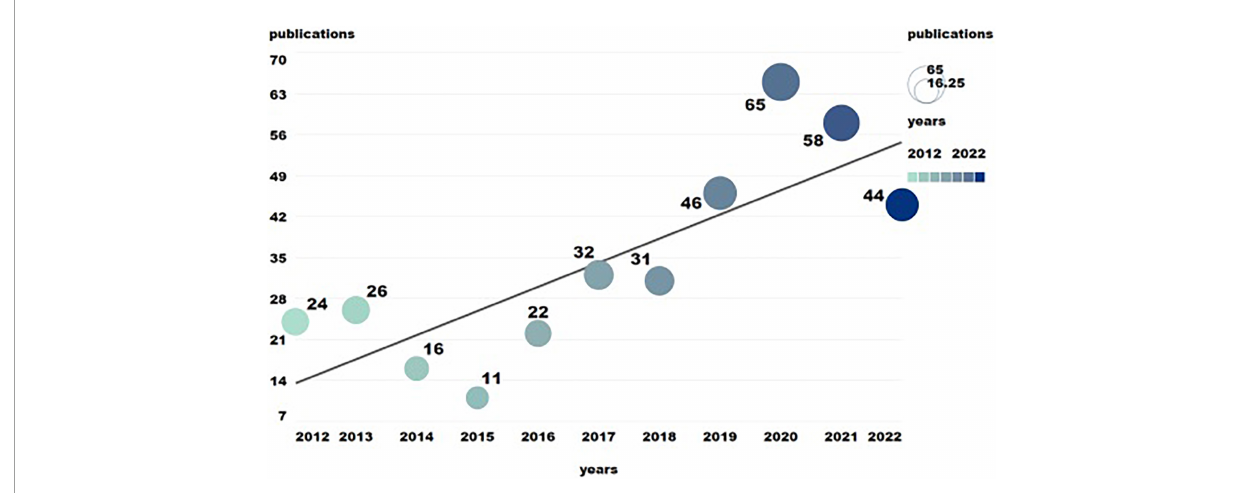
FIGURE1 The annual number of publications related to traditional Chinese non-pharmacological therapies on knee osteoarthritis (KOA).